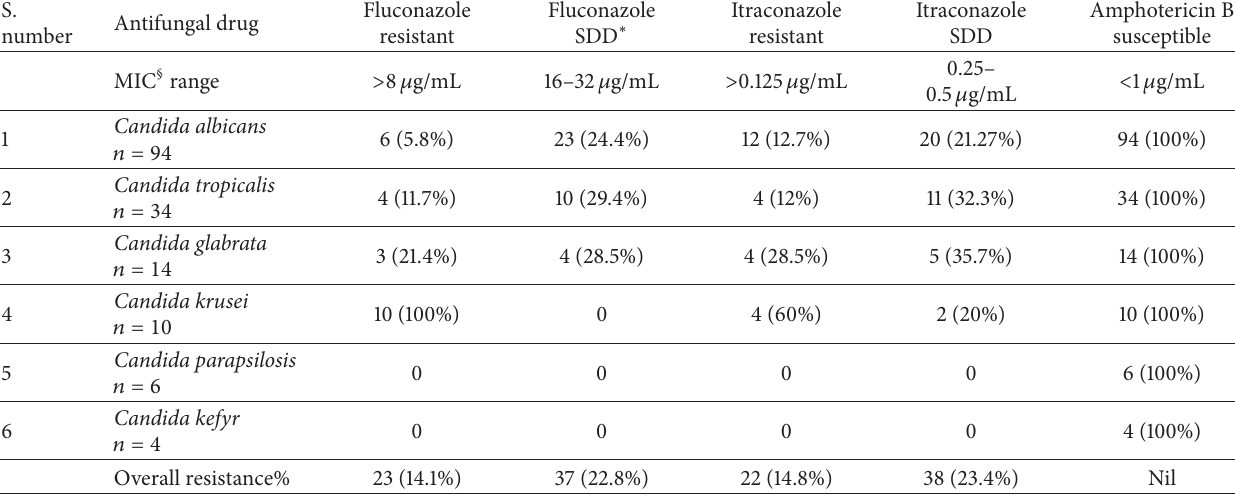
Table 5: Antifungal susceptibility pattern by Microbroth dilution